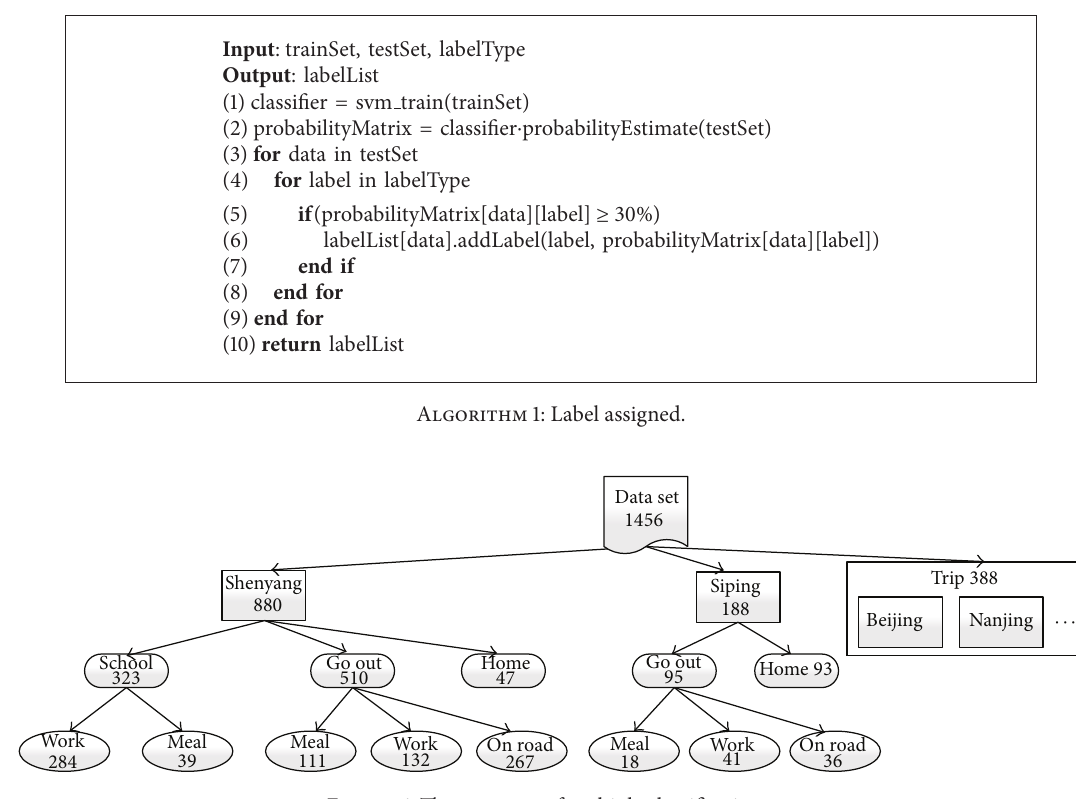
Figure 6: The structure of multiple classifications.